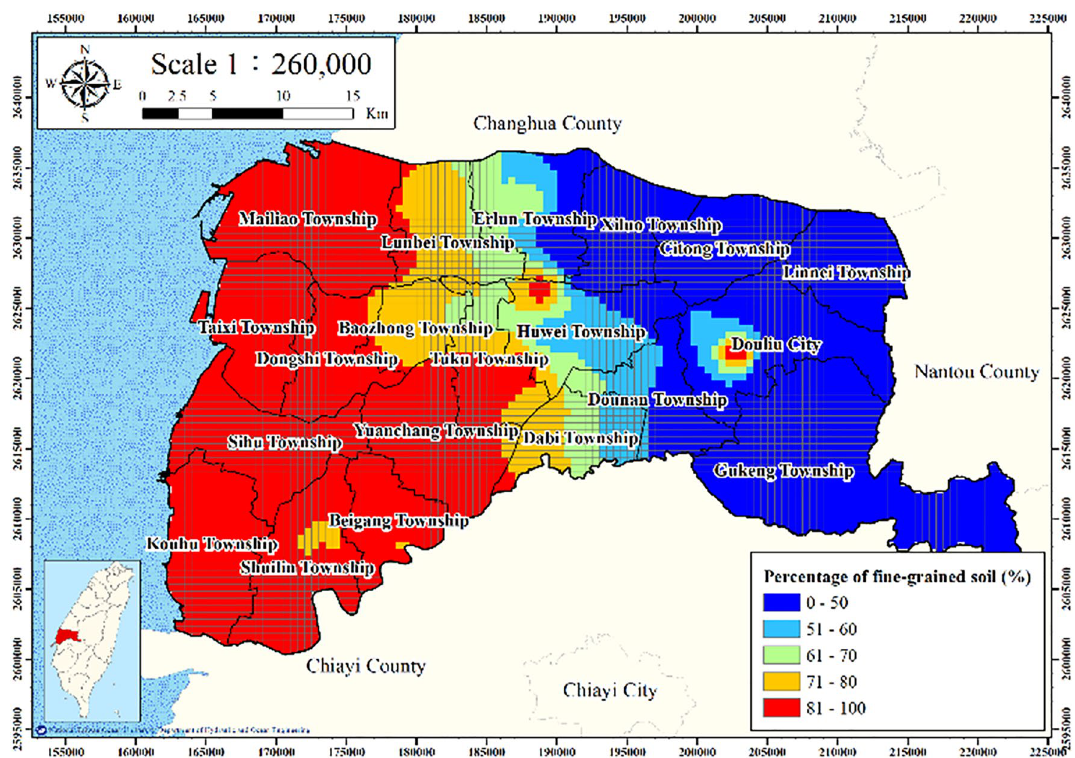
Figure 13. Cells of fine-grained soil. This figure was created using ArcGIS 10.6.1 software.